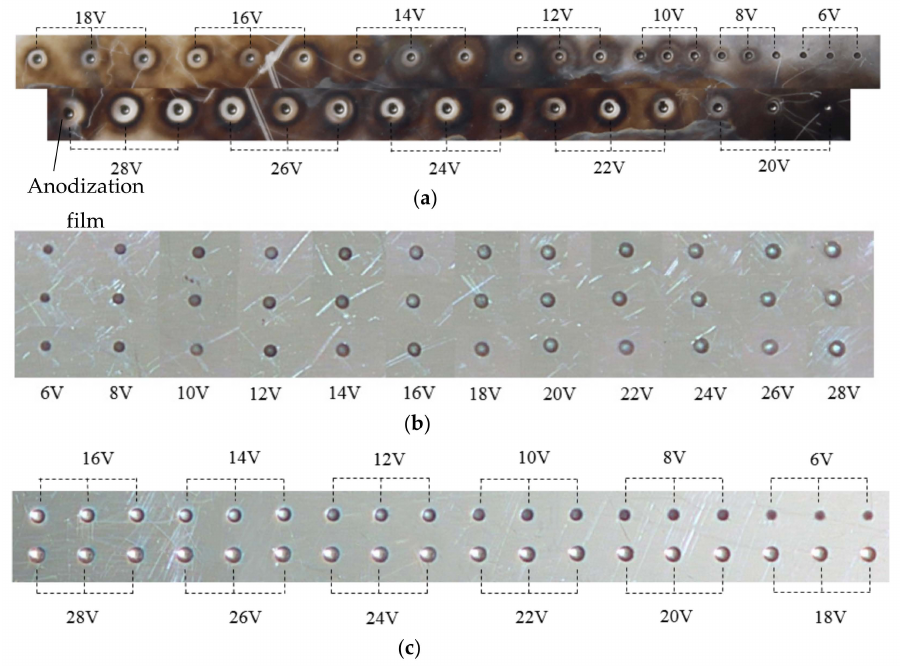
Figure 10. Photos of micro-dimples machined with di ff erent modes when the nozzle’s inner diameter was 170 µ m and working gap was 100 µ m. ( a ) Vertically downstream mode; ( b ) vertically upstream mode; ( c ) horizontal